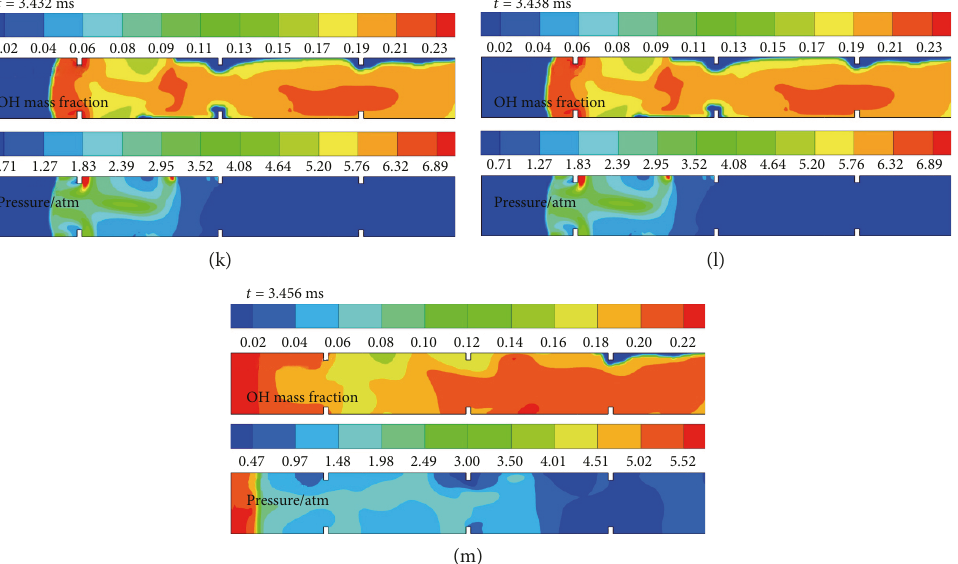
Figure 14: Detailed ignition and fl ame propagation processes in WRC.